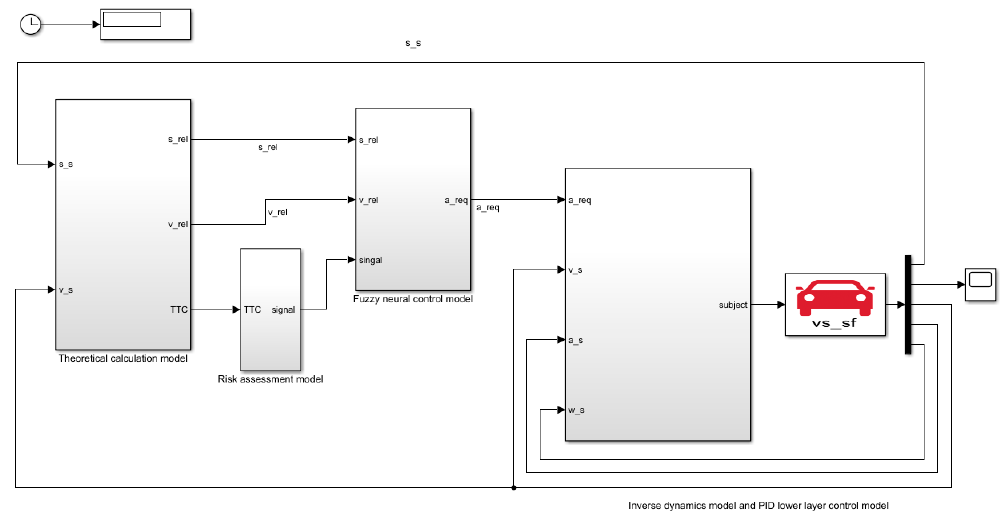
Figure 25. The AEB-P joint simulation system. Figure 25. The AEB ‐ P joint simulation system.